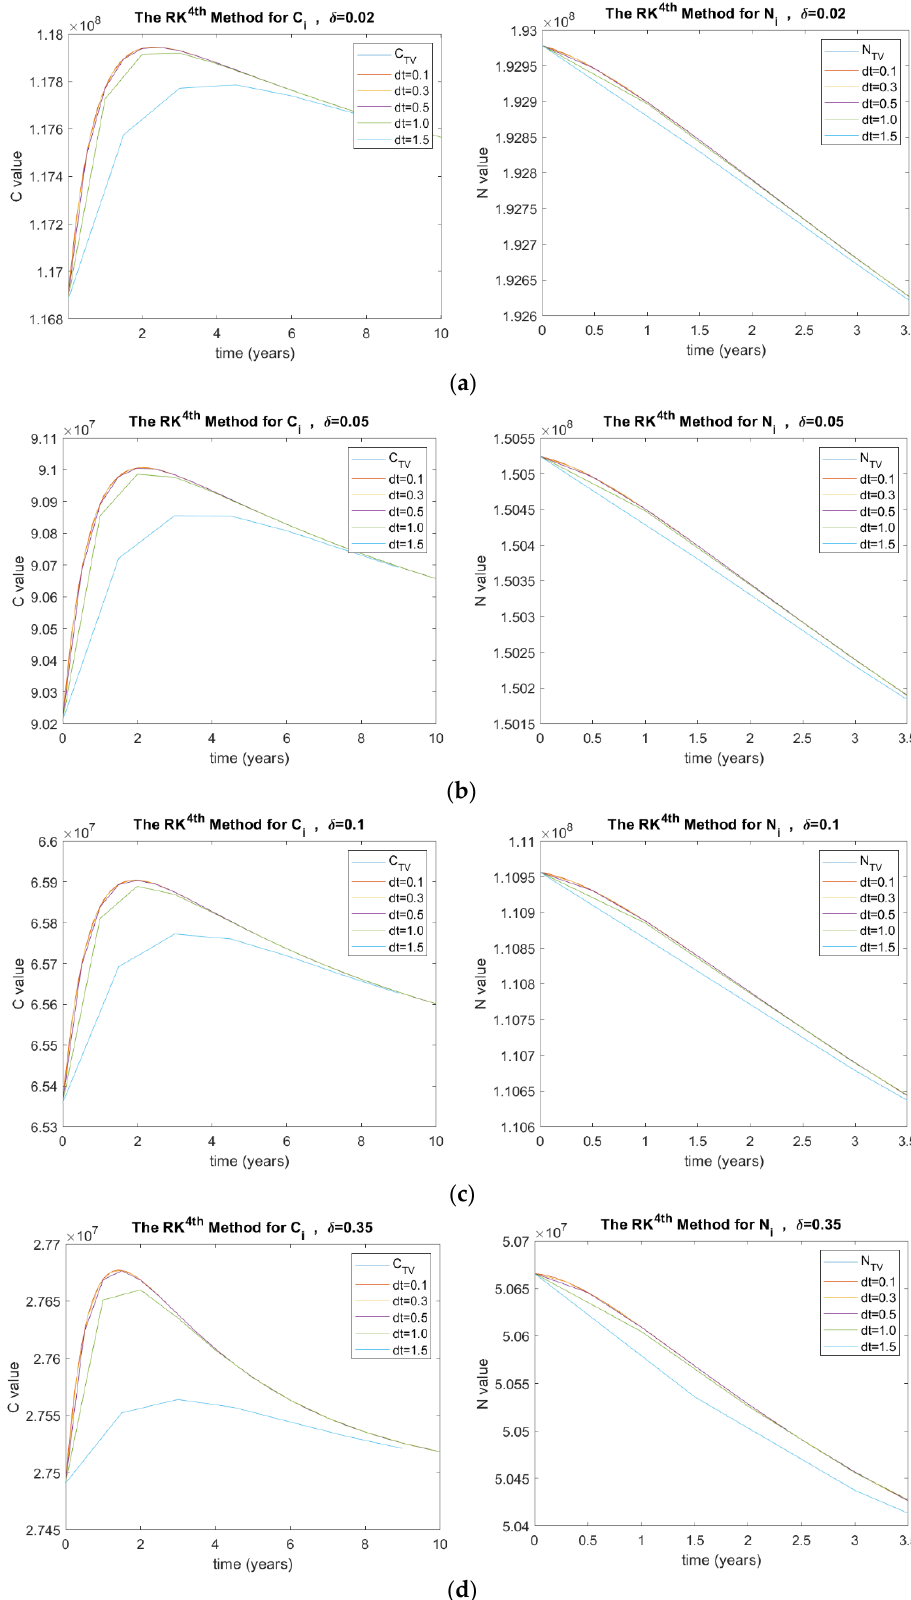
Figure 5. ( a ) Stability analysis for RK method when δ = 0.02, ( b ) δ = 0.05, ( c ) δ = 0.1, and ( d ) δ = 0.35, where C is the number of diabetic patients with complications and C TV is its true value, N is the total number of people with diabetes and N TV is its true value, and d t is the time step Natural Mortality Rate ( 𝜇 ) The investigated 𝜇 values in this paper were 0.005, 0.02, and 0.45. Figure 6 shows the results of C i and N i for the RK method in terms of 𝜇 and ∆𝑡 , where (a) 𝜇 = 0.005 , (b) 𝜇 = 0.02 , (c) and 𝜇 = 0.45.